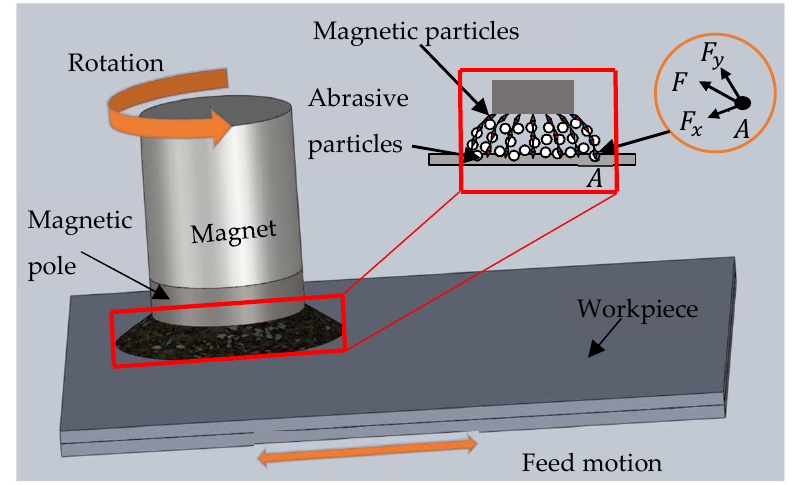
Figure 1. Schematic of finishing principle.